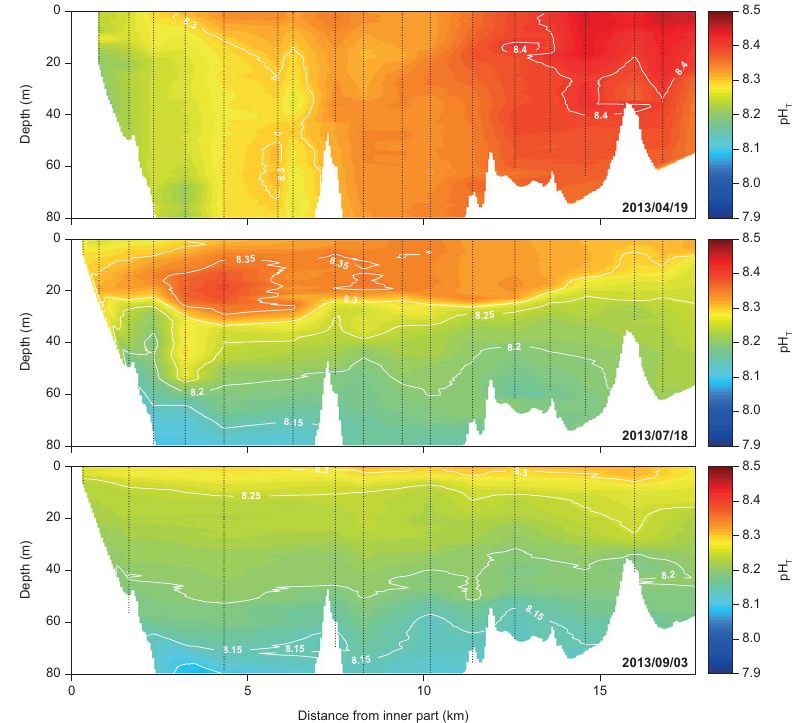
Figure 2. Fjord-scale pH variability in Kobbefjord on 19 April, 18 July and 3 September 2013.